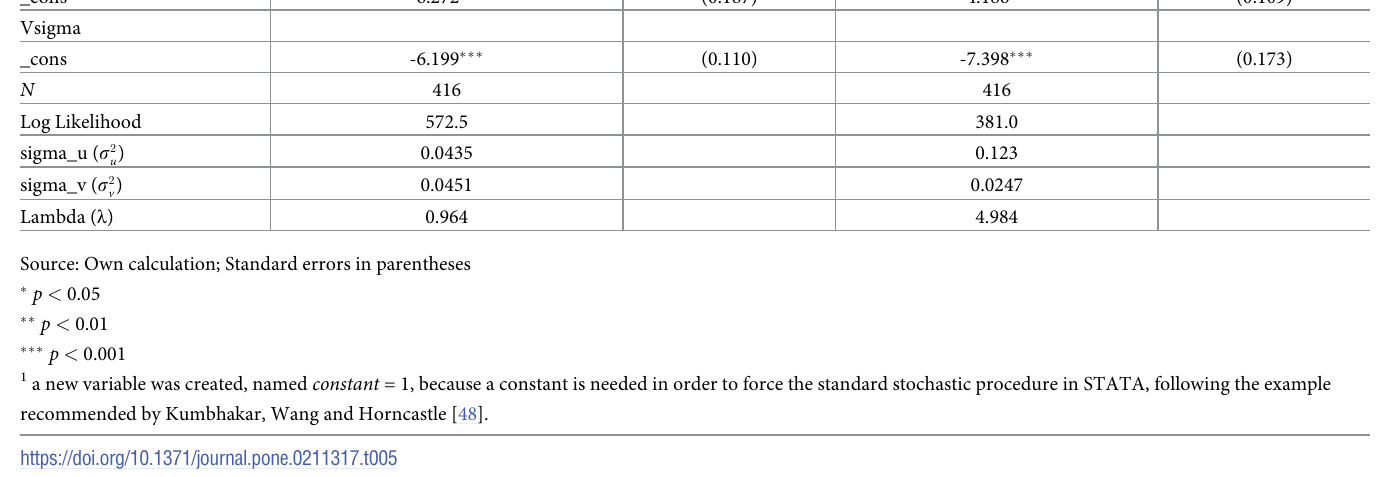
total error term is largely due to the inefficiency term. Both time-varying and persistent ineffi-